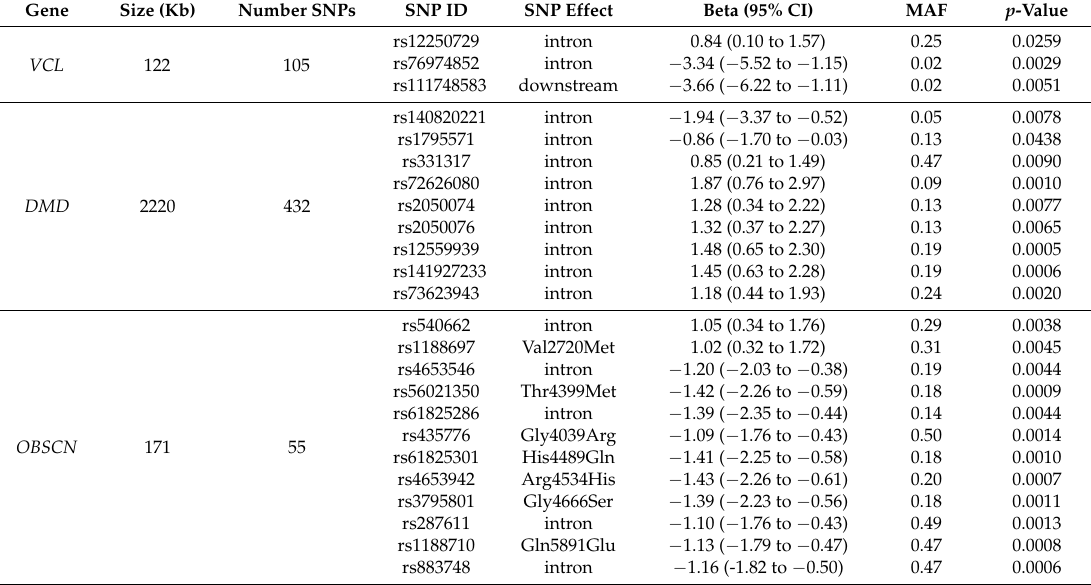
Table 2. Common variants associated with decline in LVEF following treatment with doxorubicin and trastuzumab, p < 0.05. Variants associated ( p < 0.05) with a decline in left ventricular ejection fraction (LVEF), and minor allele frequency (MAF) > 0.01. Analyses were performed for the association of single nucleotide polymorphisms (SNPs) with the maximum decline in LVEF up to two years post-treatment, by linear regression under an additive model, adjusting for baseline LVEF, age and use of anti-hypertensive medication. Variants with effects that increase the maximum decline of LVEF have negative beta values and variants which lessen the maximum decline in LVEF have positive beta